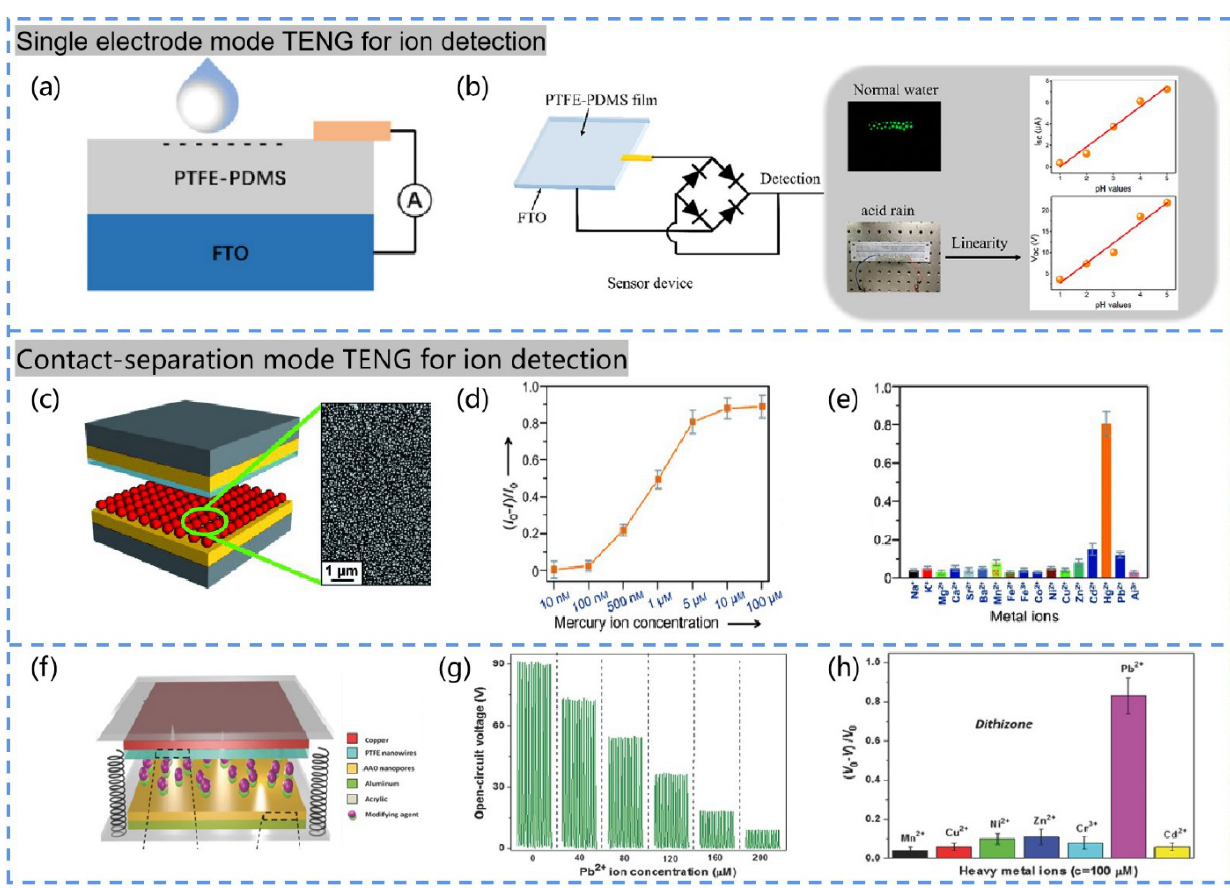
Figure 15. ( a ) Schematic diagram of a single-electrode mode TENG for sensing ions in liquid droplets. ( b ) Circuit diagram of a TENG sensor for detecting raindrops with different pH. Reprinted from [110] with permission from ACS Publications. ( c ) Schematic diagram of the structure of the contact separation TENG and the microscopic morphology of the friction layer. ( d ) Sensitivity of the TENG for Hg 2+ detection. ( e ) Selectivity of the TENG for the detection of Hg 2+ . Reprinted from [111] with permission from Wiley Online Library. ( f ) Schematic diagram of the structure of the TENG. ( g ) Plot of the relationship between the open-circuit voltage and Pb 2+ concentration. ( h ) Selectivity of the TENG-based sensor for Pb 2+ detection. Reprinted from [112] with permission from Wiley Online Library.